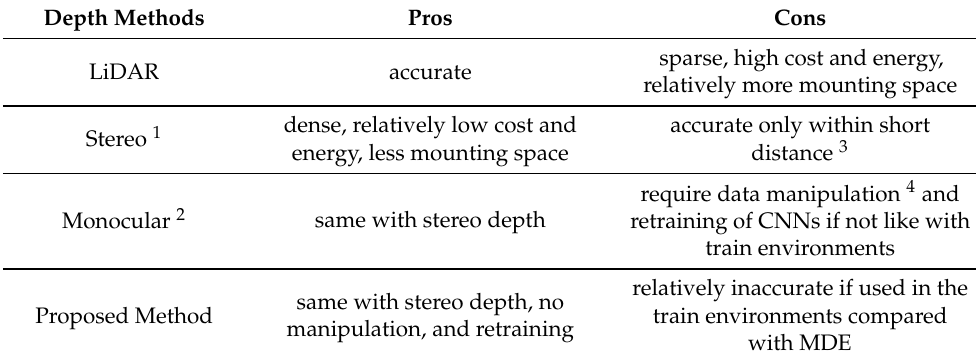
Table 5. Comparison of depth acquisition methods for small mobile